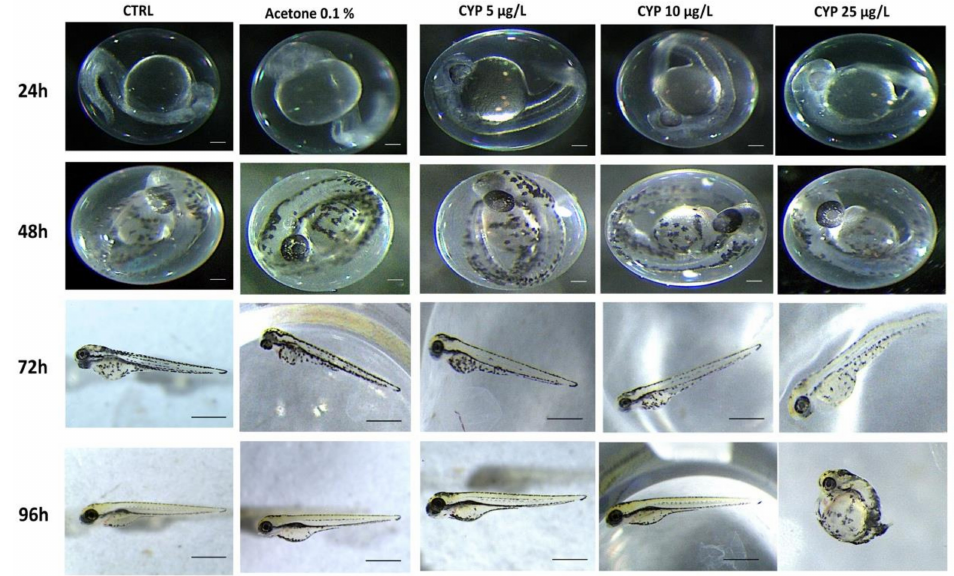
Figure 3. Optical micrographs showing physical malformation in comparison with control after incubation with CYP and acetone 0.1% for 96 hpf.